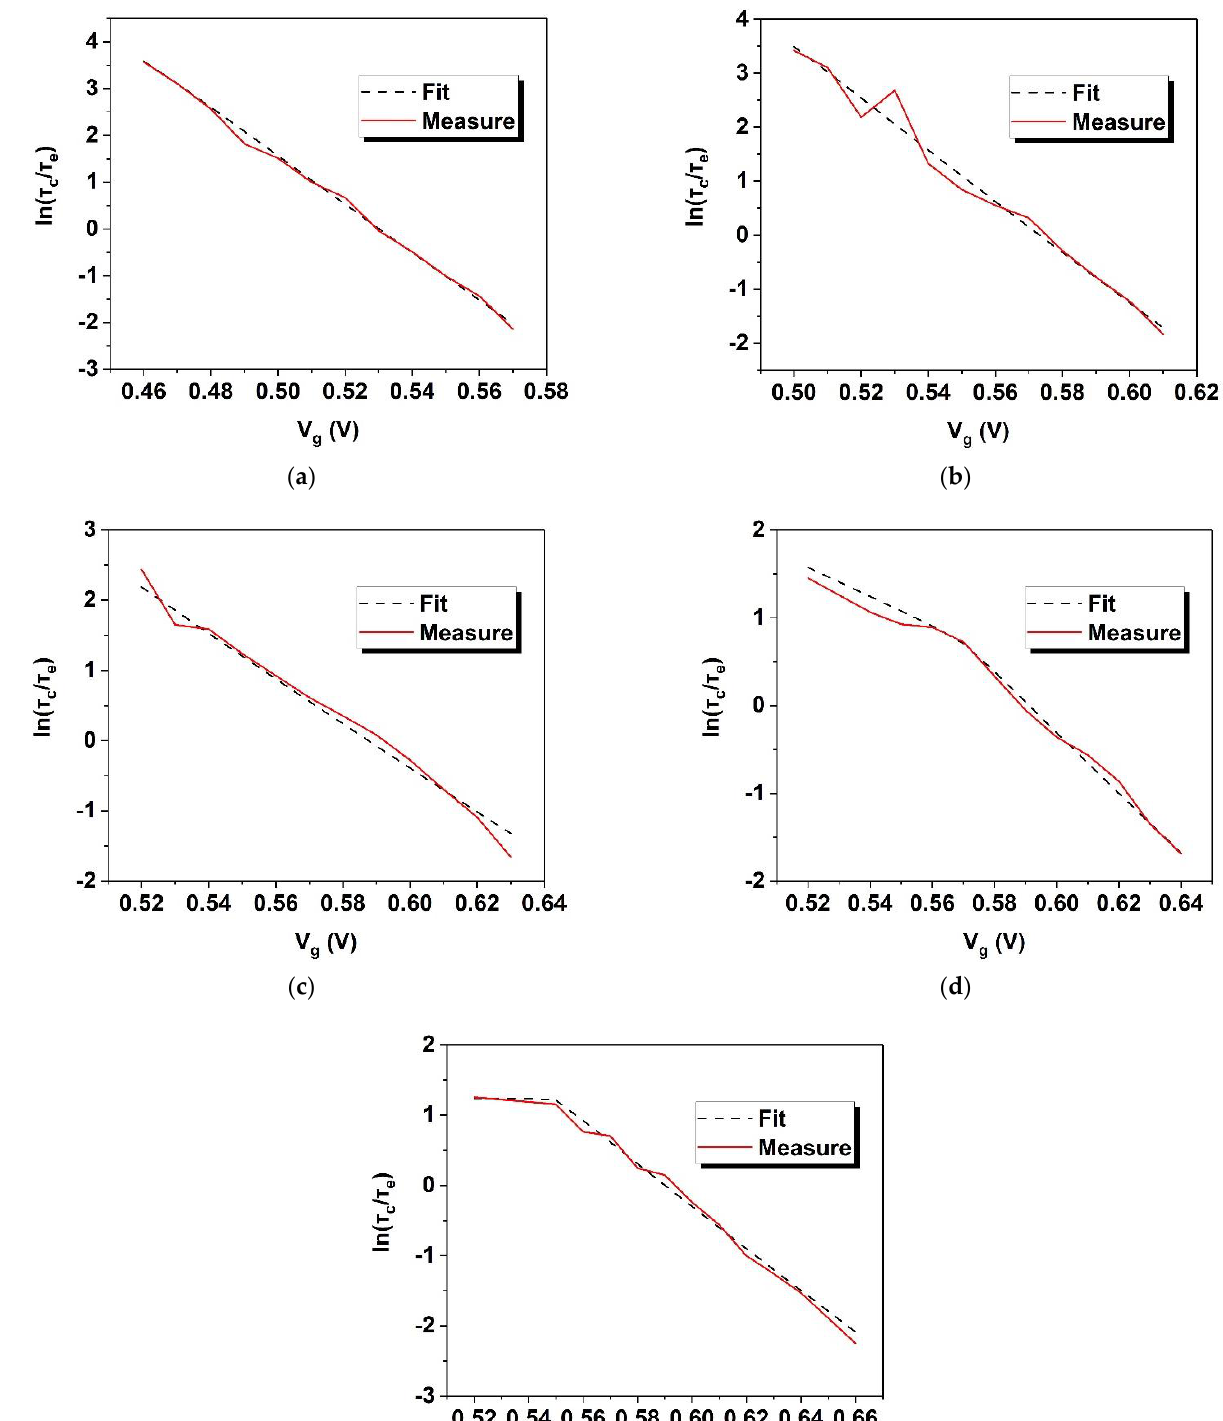
Figure 10. The measured (solid) and fitted (dashed) plots applying the parameters in Table 3 at temperatures of: ( a ) 100 K; ( b ) 77 K; ( c ) 50 K; ( d ) 25 K; and ( e ) 10 K.